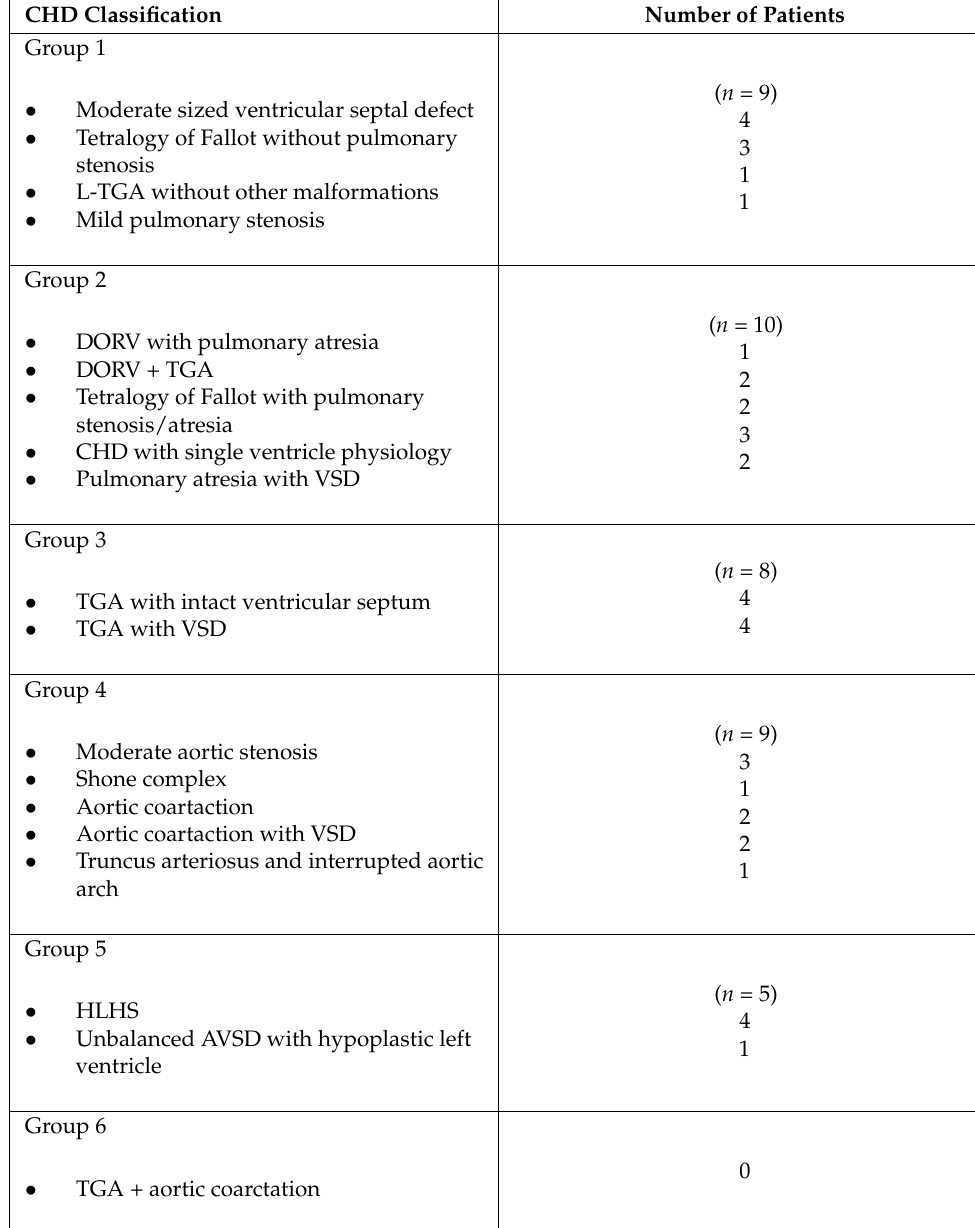
Table 2. Congenital heart disease diagnoses by